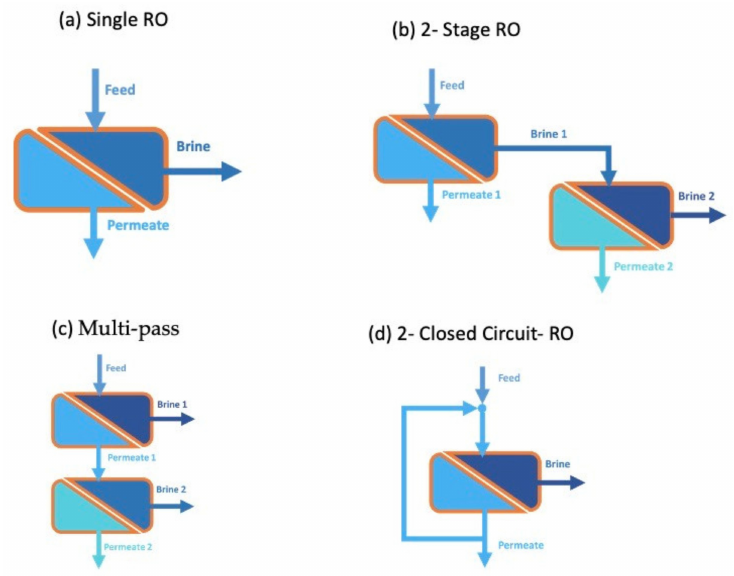
Figure 4. Different RO Configurations commonly used in desalination process. ( a ) Single RO, ( b ) 2- Stage RO, ( c ) Multi-pass and ( d ) 2- Closed